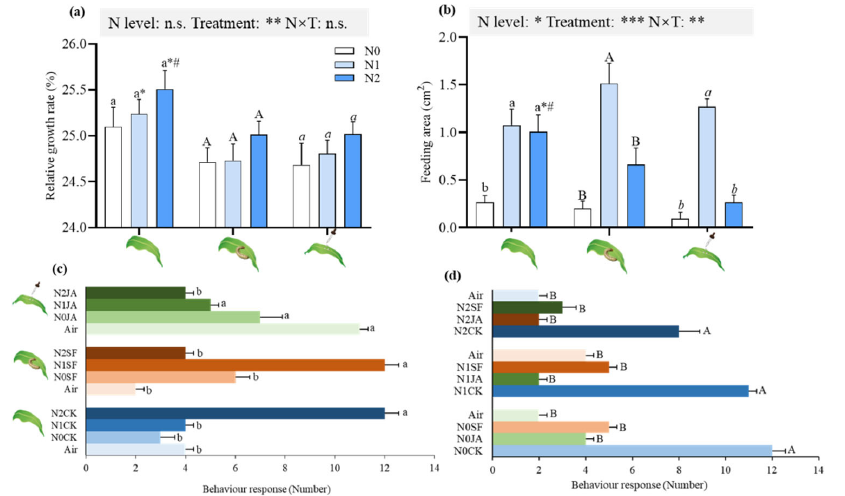
Figure 1. Effects of Nitrogen (N) supply on the aboveground biomass of maize under different in ‐ duced treatments (herbivore attack or JA application). Generalized linear models (GLM) results of testing for N level and induced treatment effects are shown (n.s., not significant; * p < 0.05; *** p < 0.001); different lowercase, uppercase and italic lowercase letters above the bars indicate significant differences among different N levels (supplemented with 0, 52.2, 156.6 mg/kg of N, denoted as N0, N1, N2) under the same induced treatments at p < 0.05 (one ‐ way analysis of variance (ANOVA)). The asterisk “*” above the bars indicates significant differences between maize with and without S. frugiperda attack; “#” above the bars indicates significant differences between maize with and without JA application by t -test.